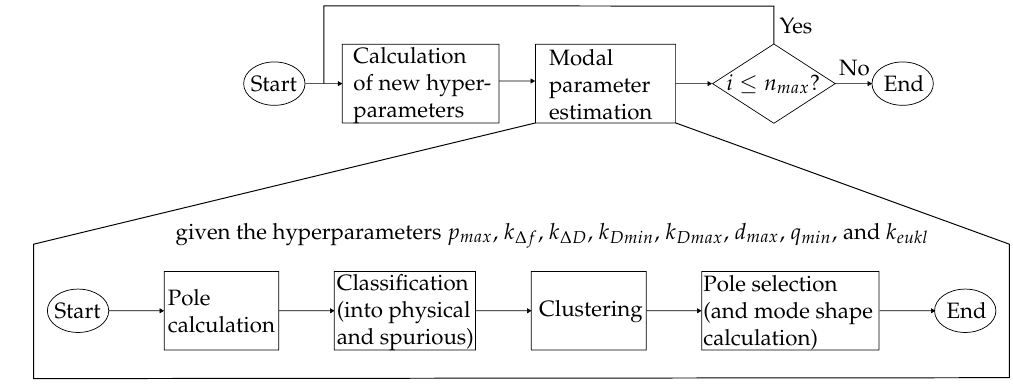
Figure 1. Flowchart showing the AutoEMA method; the modal parameter estimation is based on a set of hyperparameters explained in Table 1. Their value is determined by a Bayesian optimization strategy such that the resulting model optimally replicates the original input data.